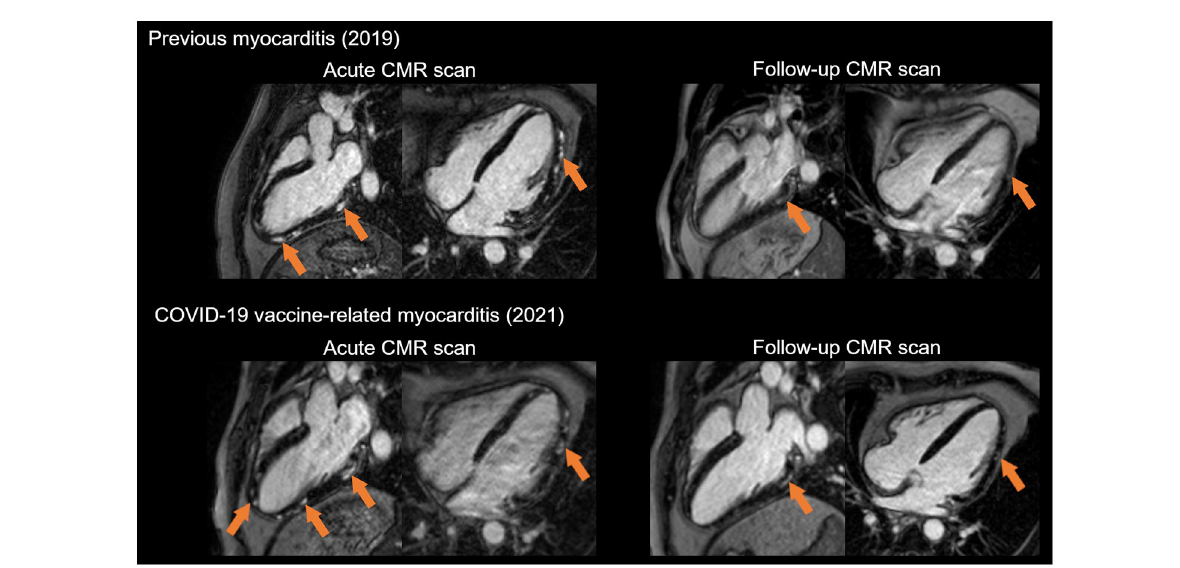
FIGURE2 Recurrent myocarditis in a young male patient after the second dose of anti-COVID-19 vector vaccine. Our patient had prior myocarditis in 2019. At the time, he presented with chest pain preceded by gastrointestinal infection and fever. He had elevated troponin levels, and the CT coronary angiogram was negative. The acute CMR showed patchy subepicardial oedema and late gadolinium enhancement (LGE) (orange arrows). Three months later, on his follow-up scan, the oedema disappeared, and the LGE shrank. In 2021, the patient experienced fever and recurrent chest pain 2 days after the second dose of the COVID-19 vaccine. His acute CMR imaging showed LGE in a similar pattern as during the first acute myocarditis episode. Notably, signs of myocardial injury resolved on the follow-up